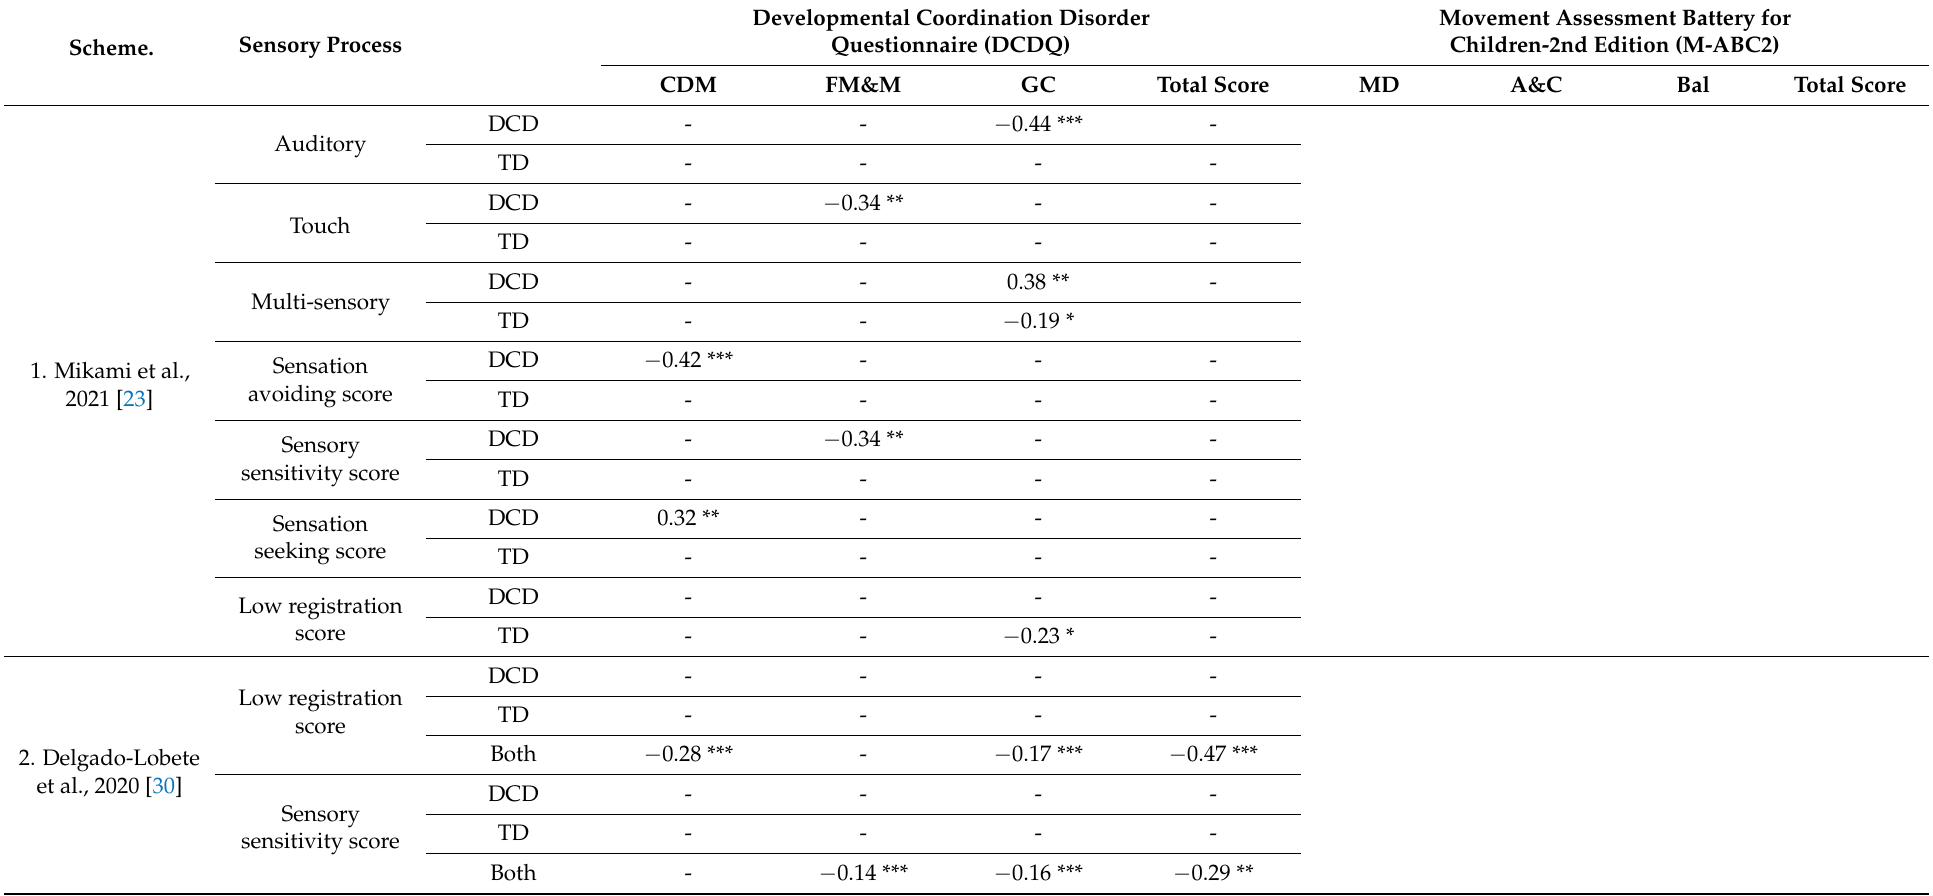
Table 3. Correlations between sensory processing impairment and motor coordination